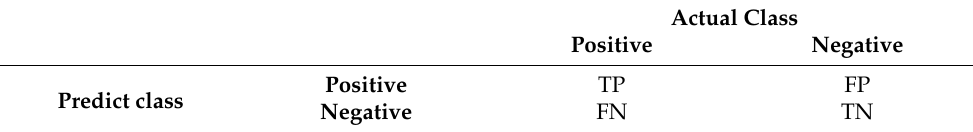
Table 1. A simple binary classification confusion matrix.